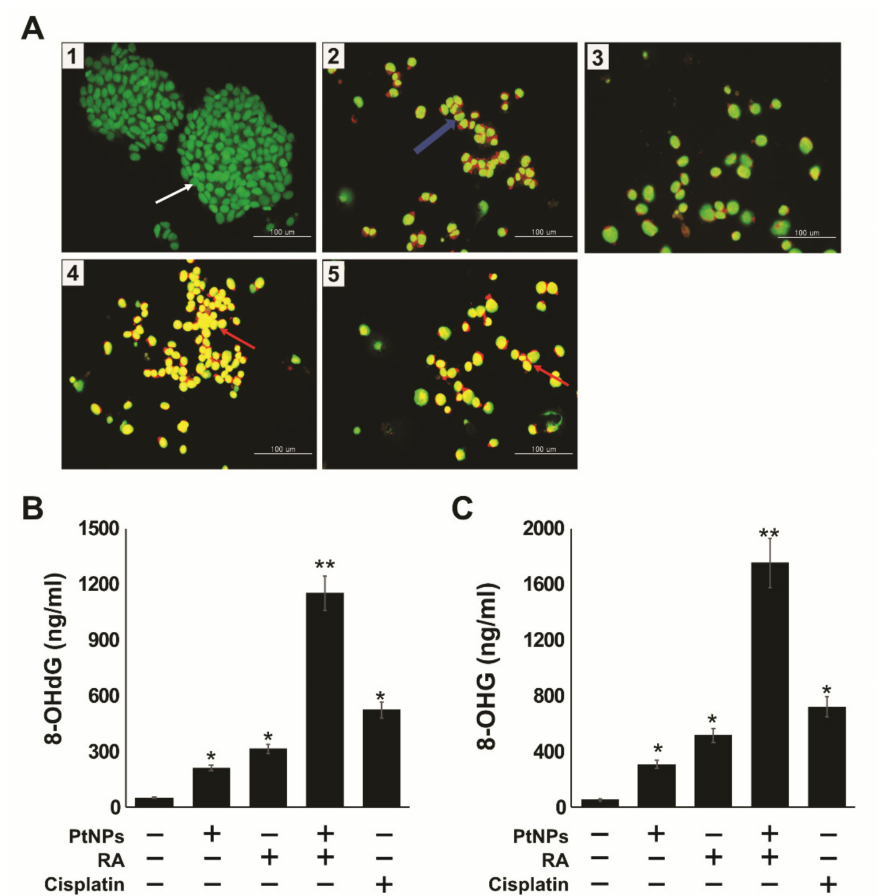
Figure 10. PtNPs and RA induce apoptosis and accumulation of 8-OHdG and 8-OHG.SH-SY5Y cells were incubated with PtNPs (25 µ g / mL), RA (12.5 µ M), combination of PtNPs (25 µ g / mL) and RA (12.5 µ M), or cisplatin (6.5 µ M) for 24 h. Morphologic observation with acridine orange / ethidium bromide (AO / EB) staining ( A ). SH-SY5Y cells were treated without (1), with PtNPs (2), RA (3), PtNPs and RA (4), or cisplatin (5) for 24 h. White color arrow indicates viable cells, blue color indicates early apoptotic cells, and red color indicates late apoptotic cells. Each experiment was performed in triplicate ( n = 3). Original magnification was 200 µ m. The level of 8-OHdG was measured by ELISA after 24 h of exposure ( B ). The level of 8-OHG was measured by ELISA after 24 h of exposure ( C ). The results